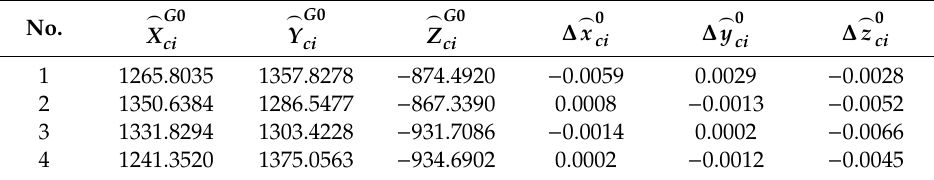
Table 5. Optimization data and correction data of global control points (unit: